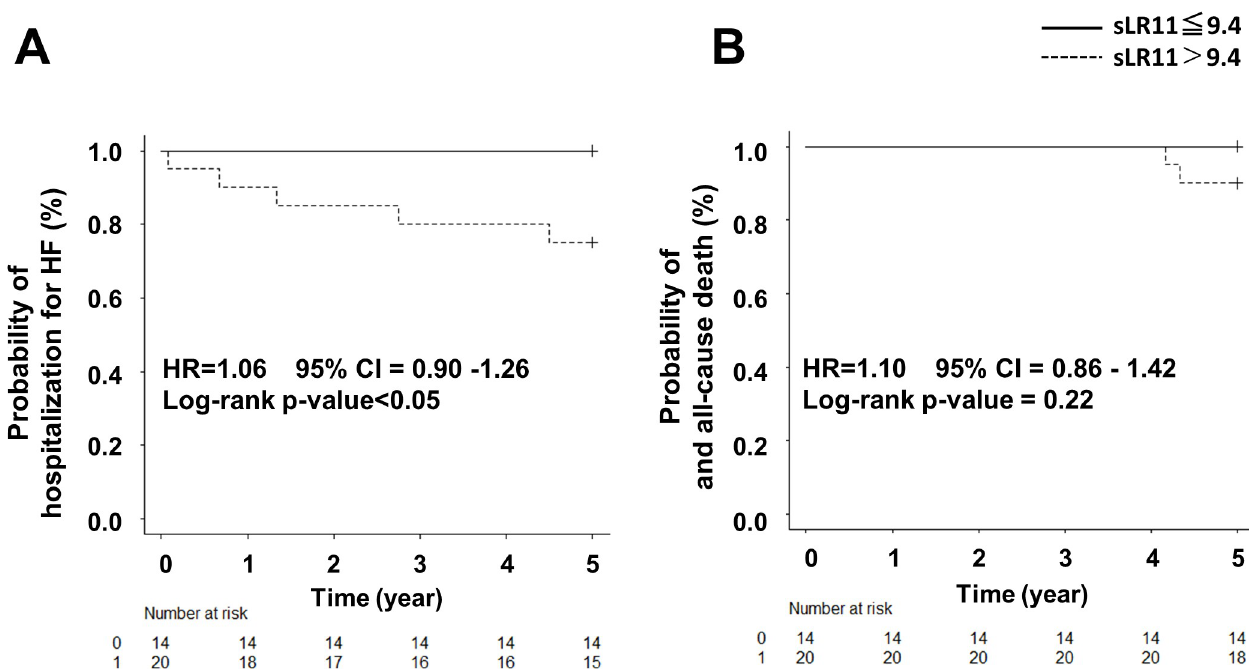
Fig 3. Event-free survival curve for heart failure hospitalization and all-cause death. A) The Kaplan-Meier curve demonstrates a significantly higher hospitalization for HF rate in the high-sLR11 group (sLR11 > 9.4 mg/mL) than the normal sLR11 group (sLR11 � 9.4 mg/mL; p < 0.05). B) All-cause mortality was observed in the high sLR11 group, but no significant difference was observed (p = 0.22).